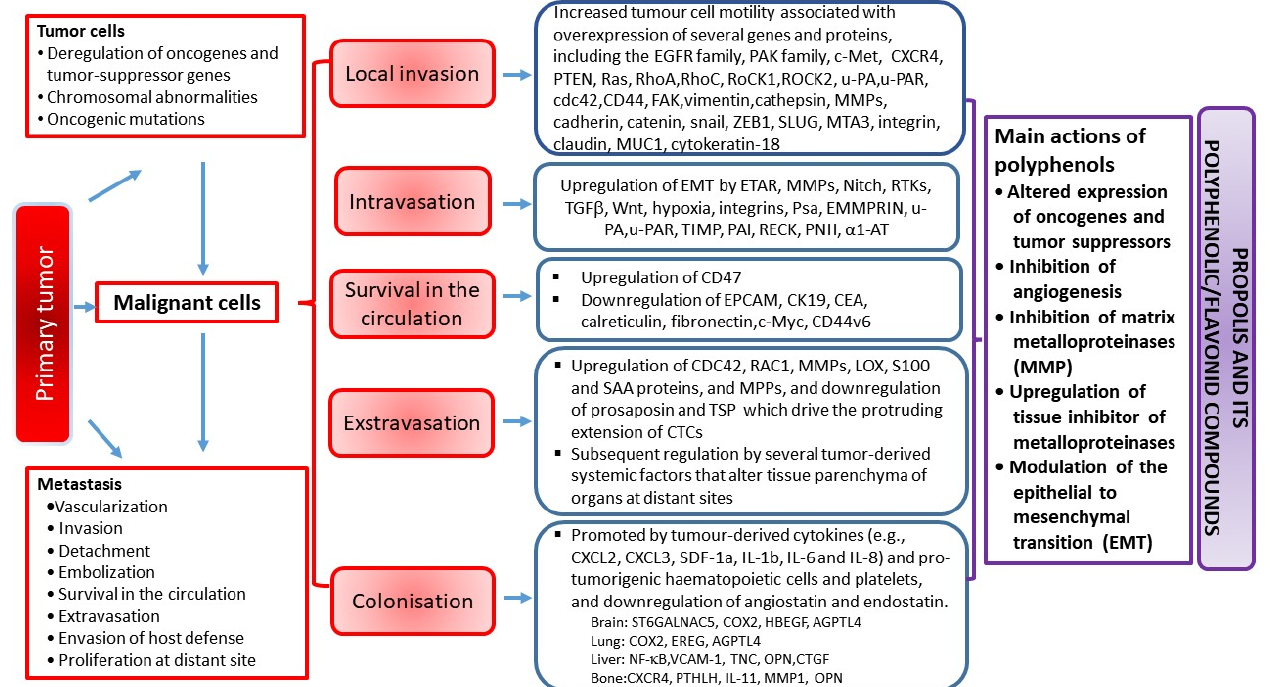
Figure 5. Antimetastatic effect of propolis and its polyphenolic/flavonoid compounds. Propolis and its components participate in all steps of the metastatic spread from the primary tumor through numerous mechanisms. Development of tumor cells includes survival, proliferation, invasion, an- giogenesis, and metastasis. Note: EGFR, epidermal growth factor receptor; PAK, p-21 activated kinases; c-Met, tyrosine-protein kinase Met or hepatocyte growth factor receptor (HGFR); CXCR4, C-X-C Motif Chemokine Receptor 4; PTEN, Phosphatase and tensin homolog; Ras, oncogen; Rho, Rac, and Cdc42, RhoA, RhoC, Rho GTPase; RoCK, Rho-associated protein kinases; uPA, Uroki- nase plasminogen activator; uPAR, Urokinase plasminogen activator receptor; ECM, extracellular matrix; EMT, epithelial–mesenchymal transition; CD44, transmembrane glycoprotein also referred to as P-glycoprotein 1; FAK, Focal adhesion kinase; MMPs, Matrix metalloproteinases; EPCAM, Epithelial cell adhesion molecule; ZEB1, Zinc finger E-box-binding homeobox 1; SLUG, Zinc finger protein SNAI2; RECK, Reversion-inducing cysteine-rich protein with kazal motifs; CCL2, C-C mo- tif chemokine ligand 2; MUC1, Mucin 1; ETAR, Endothelin type A receptor; TGF β , Transforming growth factor β ; Twist, basic helix-loop-helix factors; SDF1, stromal cell-derived factor 1; Snail, Slug, transcription factors of a snail family; TIMPs, Tissue inhibitors of metalloproteinases; PAI, Plasminogen activator inhibitor 1; MTA3, metastasis-associated protein; EMMPRIN, extracellular matrix metalloproteinase inducer; PN-II: protease nexin-II; alpha1-AT, alpha 1-antitrypsin; EPCAM, epithelial cell adhesion molecule; CK19, Cytokeratin 19; CEA, carcinoembryonic antigen; SAA, serum amyloid A; LOX, protein-lysine 6-oxidase; RAC1, Ras-related C3 botulinum toxin substrate1; cdc42, cell division control protein 42 homolog; S-100, S-100 protein; ST6GALNAC5, α 2,6-sialyltransferase; AGPTL4, Angiopoietin-like (ANGPTL) protein; OPN, Osteopontin; CXCR4, chemokine receptor 4; EREG, epiregulin; COX-2, Cyclooxygenase-2; TSP, Thrombospondin; CTCs, circulating tumor cells; VCAM-1, Vascular cell adhesion molecule 1; TNC, tenascin C; CTGF, Connective tissue growth factor, NF- κ B, Nuclear factor kappa-light-chain-enhancer of activated B cells; PTHLH, parathyroid hormone-like